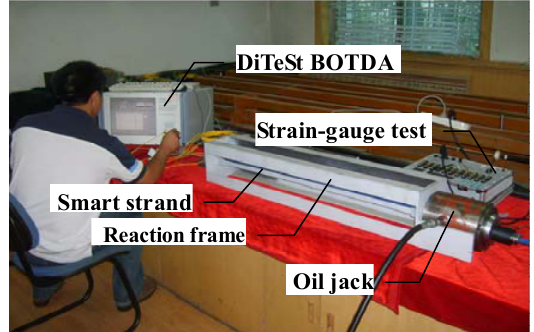
Figure 5. Setup of calibration tests.